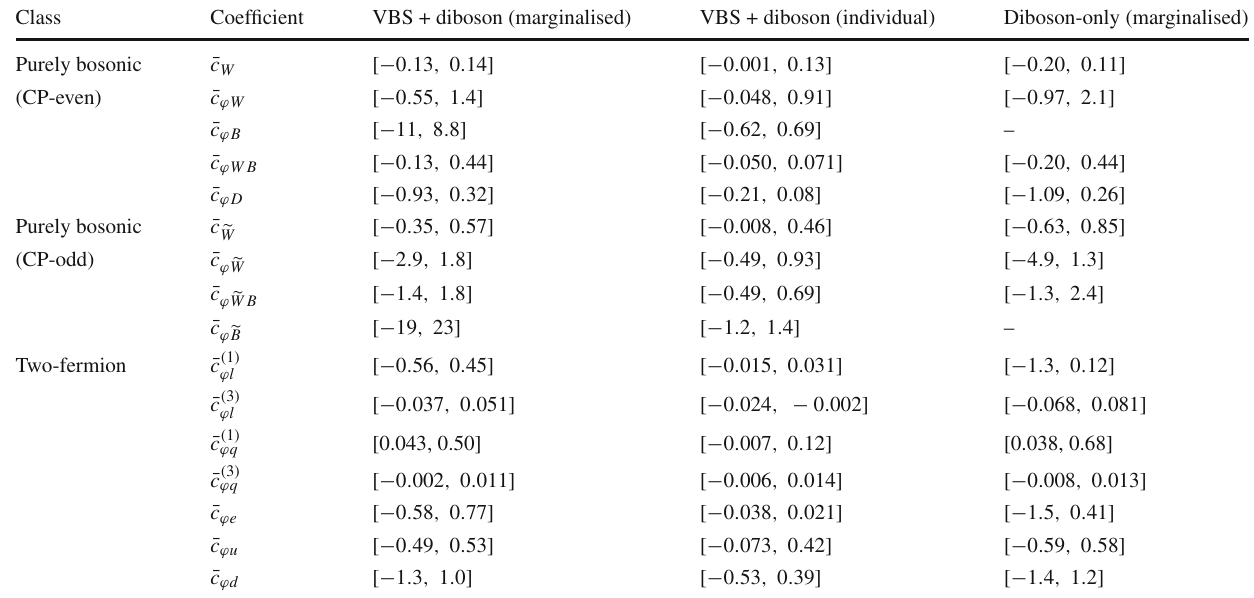
Table 9 The 95% confidence level intervals associated to the 16 dimension-six EFT degrees of freedom considered in the present anal- ysis. We compare the results of fits based on the baseline VBS + dibo- son dataset both at the global (marginalised) and the individual lev-